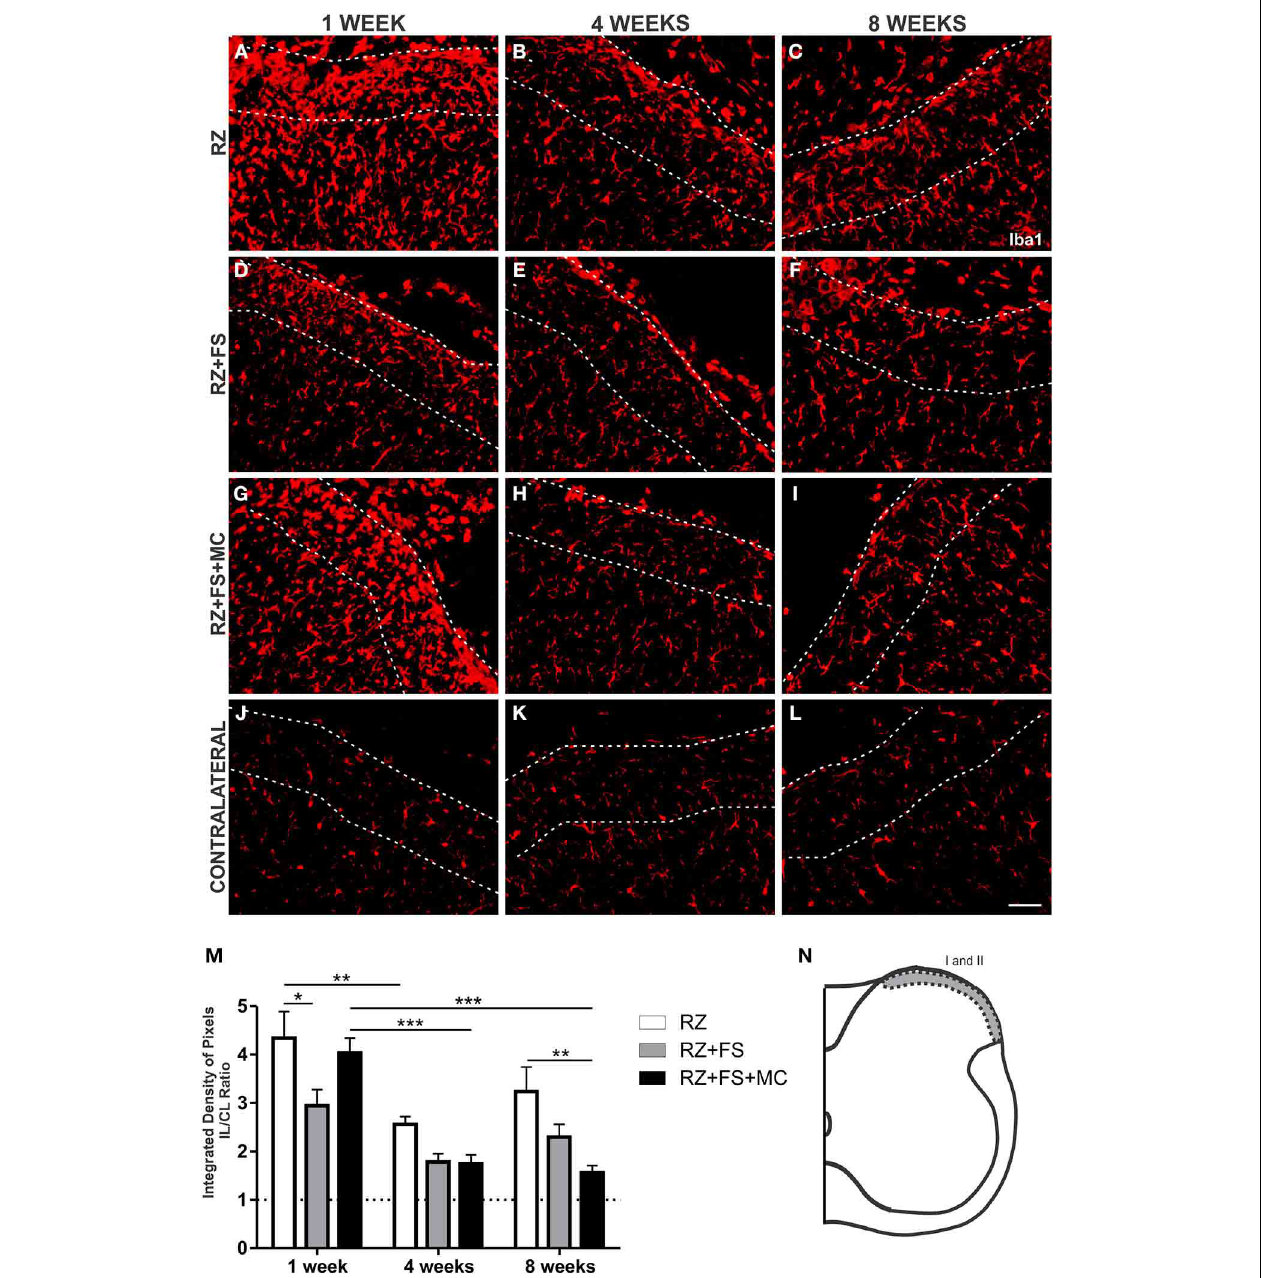
FIGURE 6 | Immunohistochemistry for ionized calcium binding adaptor protein (Iba1). (A–L) Representative images of RZ, RZ + FS and RZ + FS + MC, 1, 4, and 8 weeks post lesion. (M) Quantification (ratio IL/CL) of the integrated density of pixels, obtained in the region